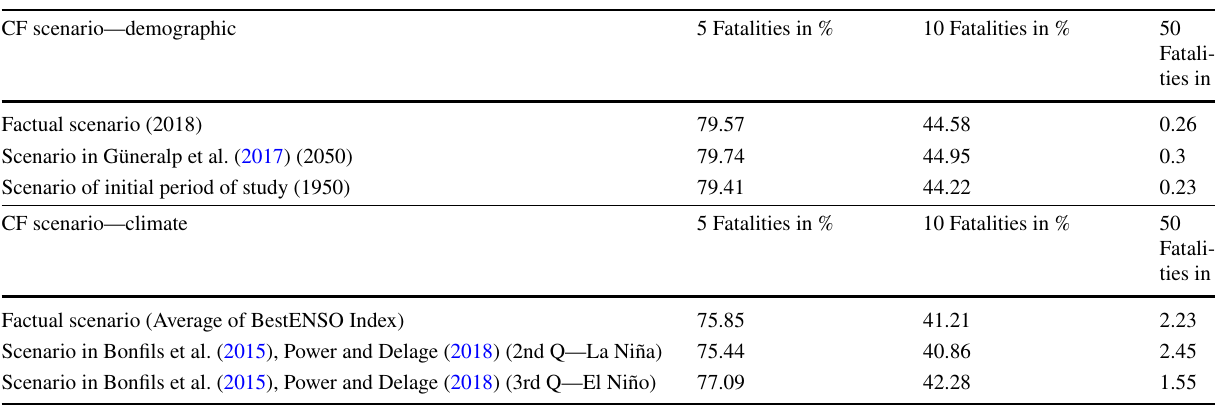
Fig. 3 Diagnostic plots. The plots include: a the quantile and quantile (QQ) plot of the data quantiles against the fitted model quantiles; b a QQ plot of quantiles from model simulated data against the data; c a